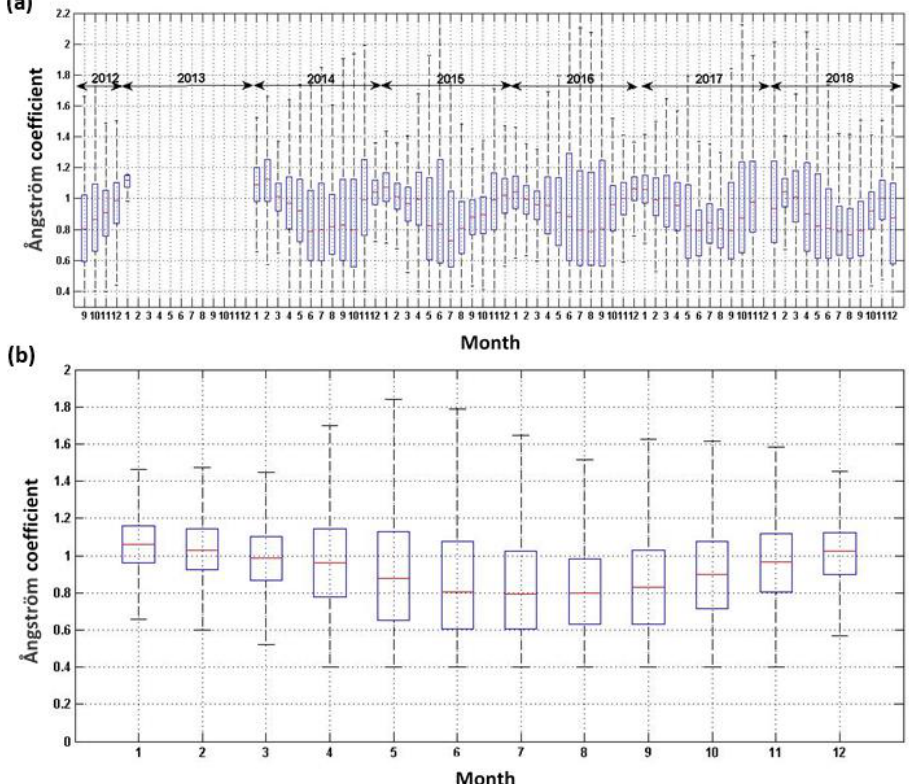
Figure 6. ( a ) Evolution of the absorption Ångström coe ffi cient over the entire measurement period; ( b ) seasonal variations of this same parameter. Red lines represent the median value, bottom and top sides of the boxes symbolize the 25th and 75th percentile, respectively. The length of the whiskers represents 1.5 × interquartile range which includes 99.3% of the data.